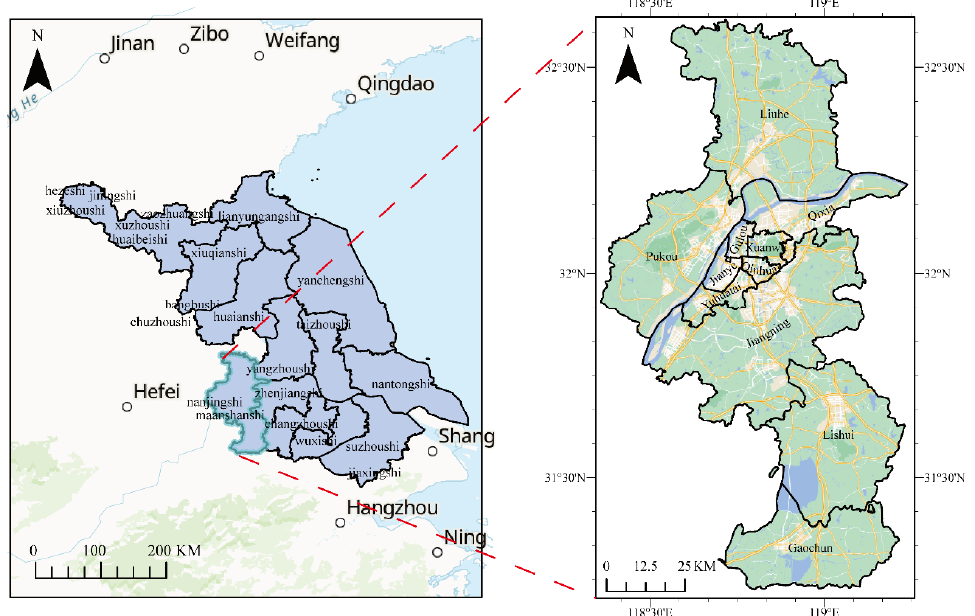
Figure 4. Study area, Nanjing.